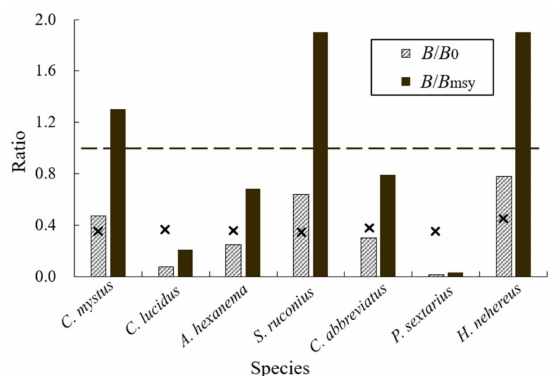
Figure 3. The current exploitation status of seven dominant fish species in the Min River Estuary in 2015–2017. “ B / B 0 ” signifies the ratio of current biomass to the unfished biomass, while “ B / B msy ” designates the ratio of the current biomass to the biomass under the condition of maximum sustainable yields. The horizontal black dotted line at y = 1 represents the situation of B = B msy . Symbol “ × ” represents the optimum B / B 0 when F = M and L c = L c_opt for specific species. Three species, C. mystus , C. abbreviatus , and P. sextarius , were selected as the surrogates of these three categories, i.e., healthy, overfished, and collapsed, to demonstrate the modeling procedure of LBB (Figure 4). The LBB model was well fitted to all three fishes with Z / K values of 3.01, 2.20, and 12.30, respectively.